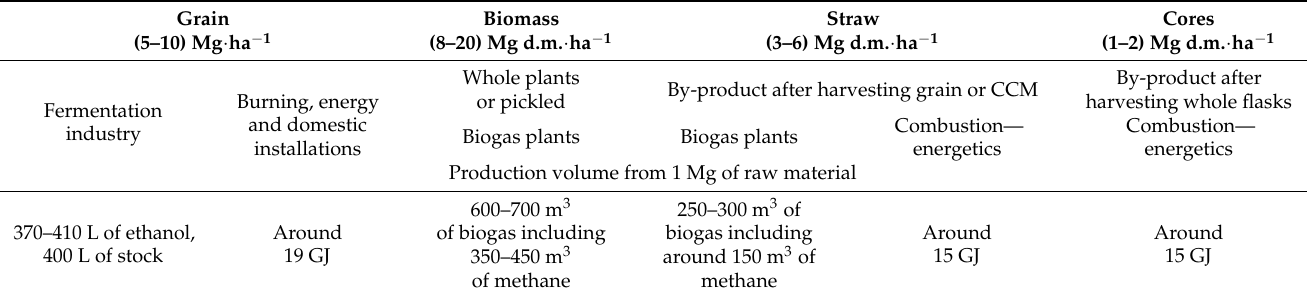
Table 7. Possibilities of using maize as an energy resource